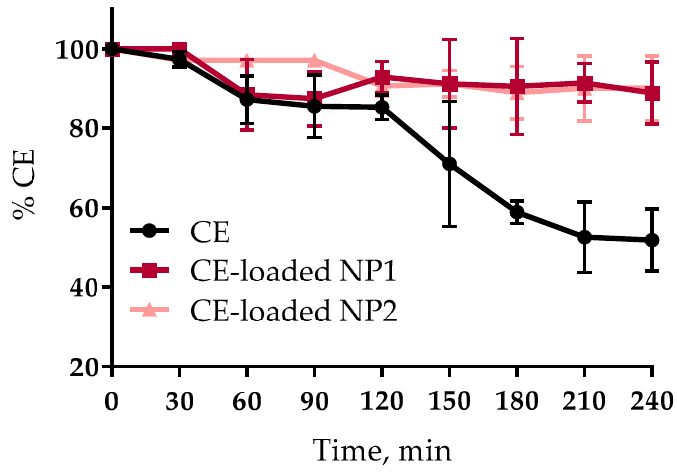
Figure 1. CE stability in simulated gastric fluids (SGFs).